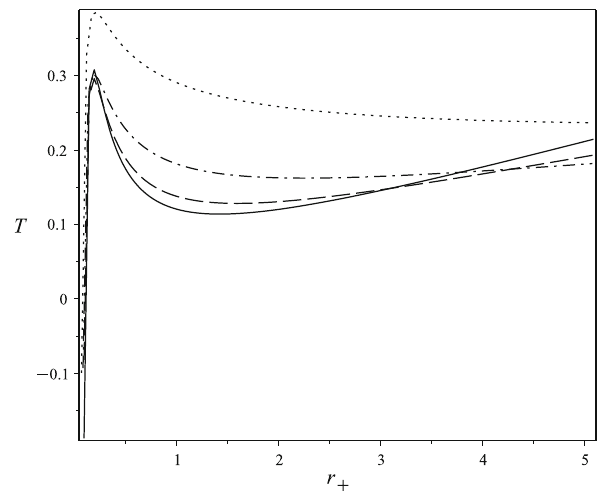
Fig. 2 Temperature as a function of horizon radius r + for several dif- ferent values of the dilaton coupling constant α in assumption that cos- mologicalconstantisfixed( (cid:2) = − 1).Thecorrespondenceofthecurves is as follows: the solid curve represents the case α = 0 . 1, the dashed curve corresponds to the choice α = 0 . 3, the dash-dotted curve repre- sents the choice α = 0 . 5 and finally the dotted curve corresponds to the case α = 0 . 7. We also note that the other parameters in Eq. (28) are held fixed, namely n = 3, b = 1 and q = 0 .